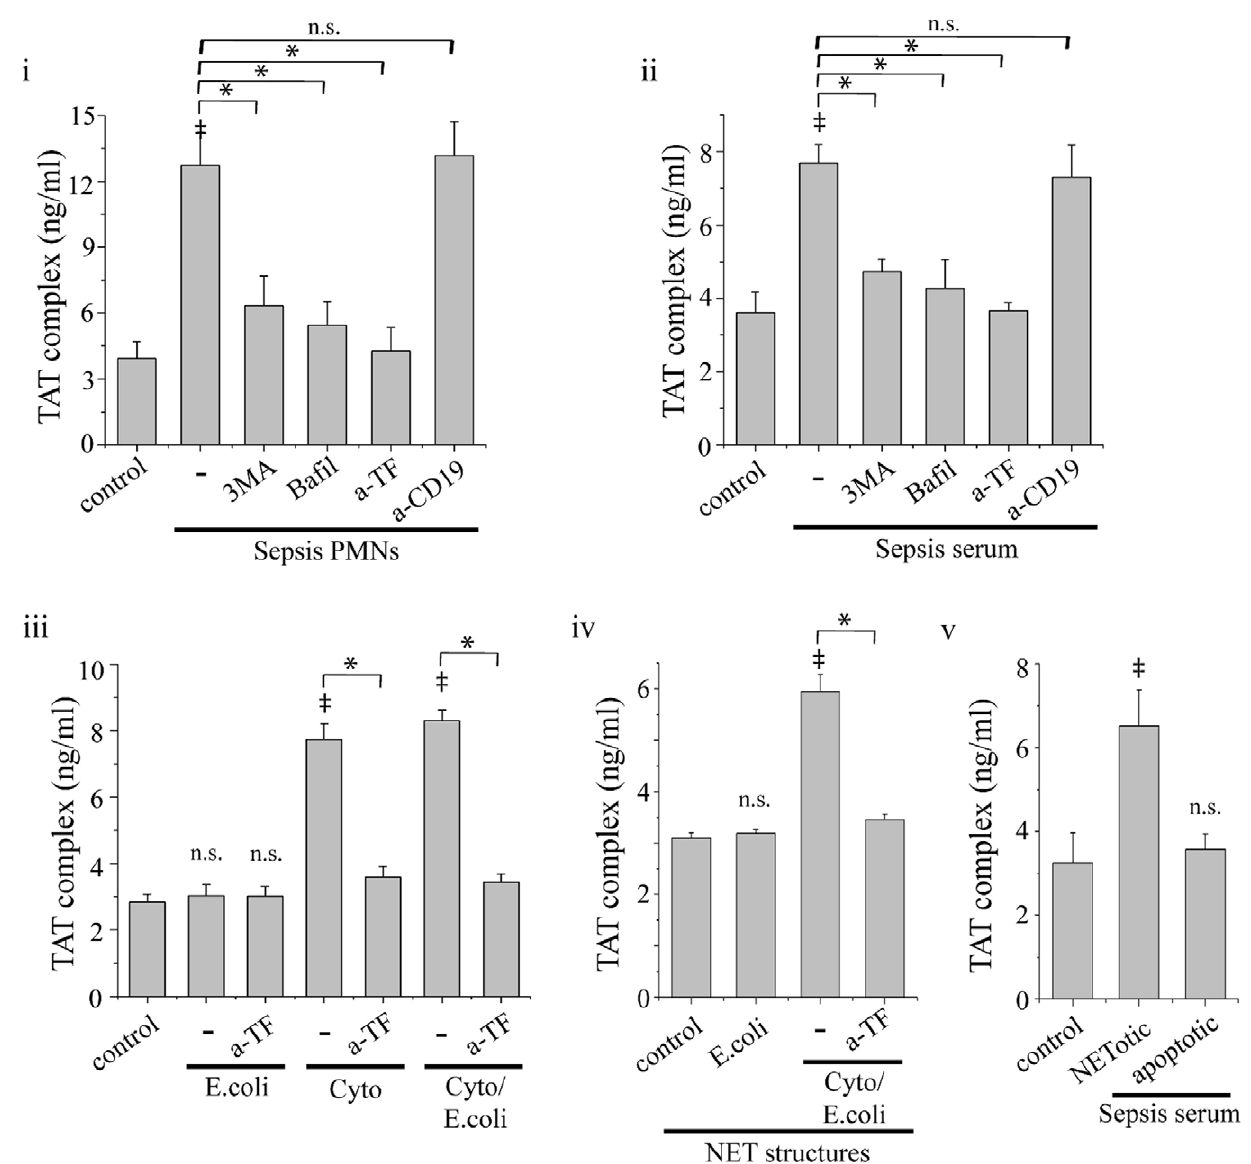
Figure 4. Thrombin generation by NET-forming neutrophils. Thrombin-antithrombin (TAT) complex levels in culture supernatants from sepsis neutrophils (i) or control neutrophils treated with sepsis serum (ii). Treatment with 3-MA, bafilomycin A1 or anti-TF mAb (a-TF) inhibited this effect. (iii) TAT complex levels in culture supernatants from control neutrophils treated with E. coli (E.coli), or TNF- a , IL-1 b and G-CSF alone (Cyto) or primed with cytokines before the addition of E. coli (Cyto/E. coli) and the respective inhibition studies using anti-TF mAb. (iv) Induction of TAT complex levels by isolated NET structures released by neutrophils treated as in (iii). (v) TAT complex levels in culture supernatants from control neutrophils treated with sepsis serum and subsequently irradiated to undergo apoptosis, or not. Control neutrophils treated with normal serum (control) and anti-CD19 mAb (a-CD19) served as control. Data are representative of four independent experiments and presented as mean 6 SD. (* P , .05, { P , .05 compared to control, ns = non